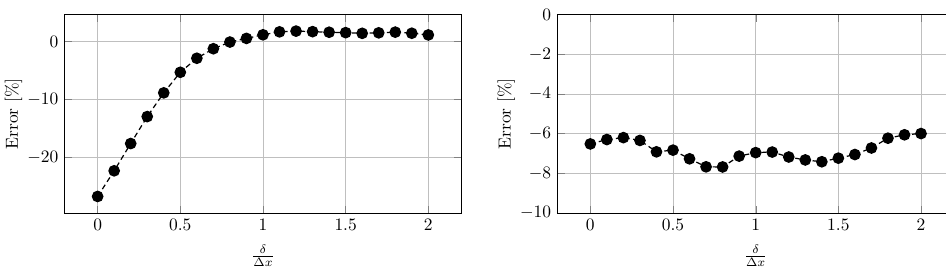
Figure 5. Drag force relative error to Schiller and Naumann [30] correlation ( left ) and Nusselt number relative error to Ranz&Marshall [31] correlation ( right ), as a function of the distance δ at Re = 100.